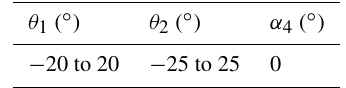
Table 2. Attitude simulation parameters of the ultrasound probe at 0 and 30mm feeding.